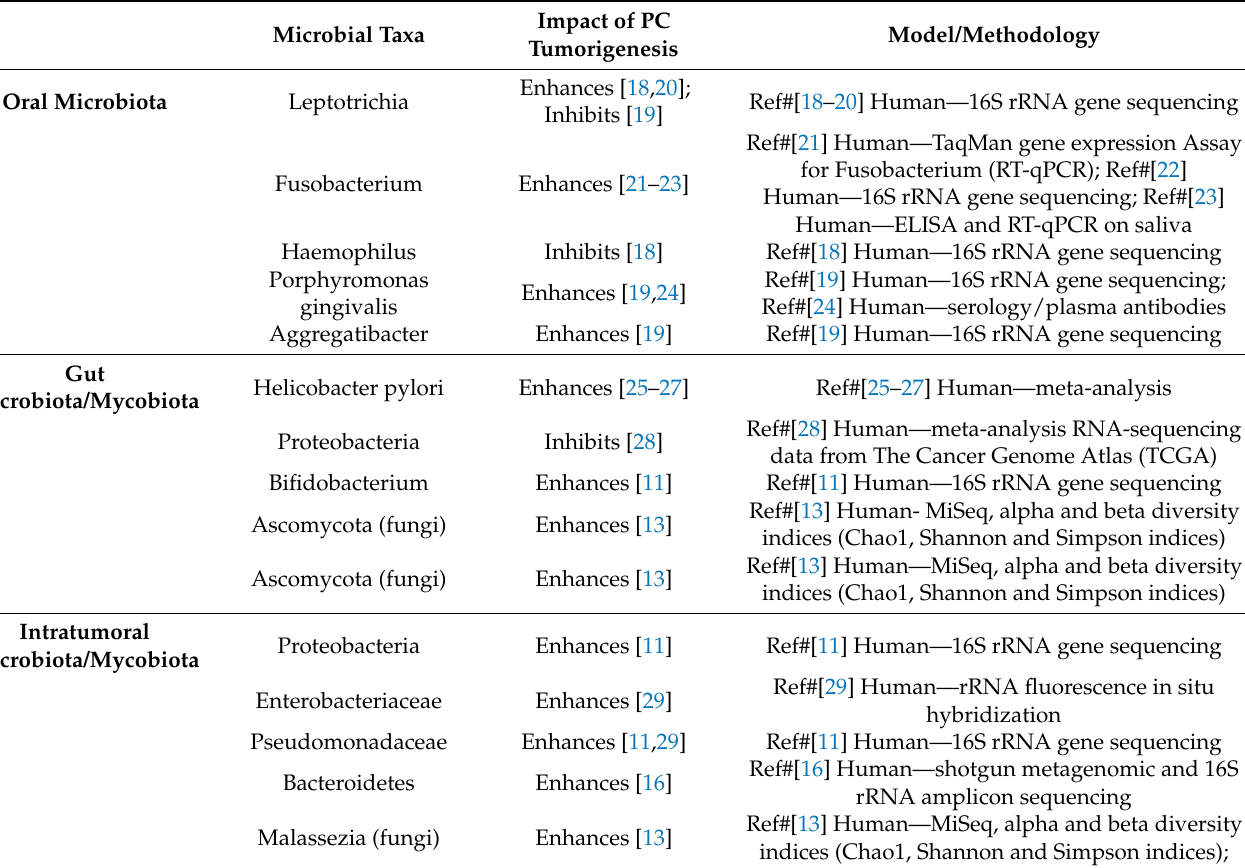
Table 1. Microbial taxa with propensity to cause pancreatic cancer. Microbial